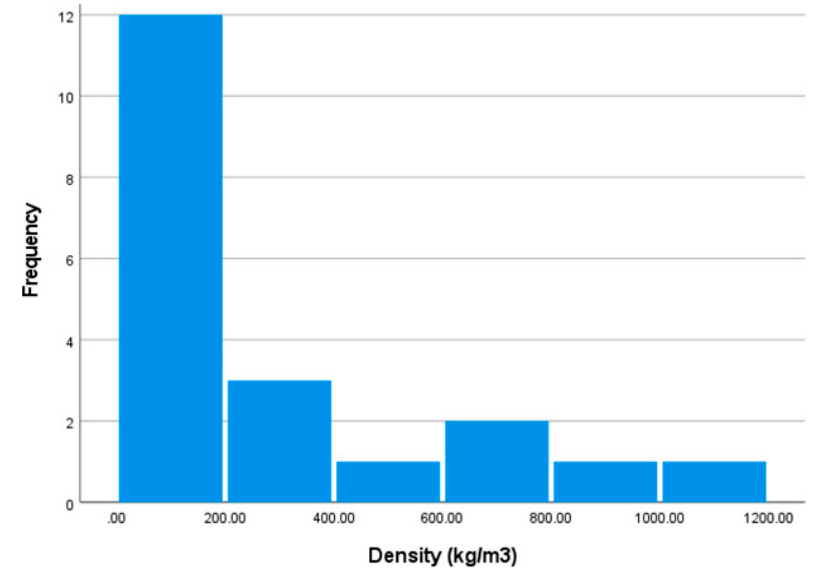
Figure 6. The distribution of FL density according to the given class.